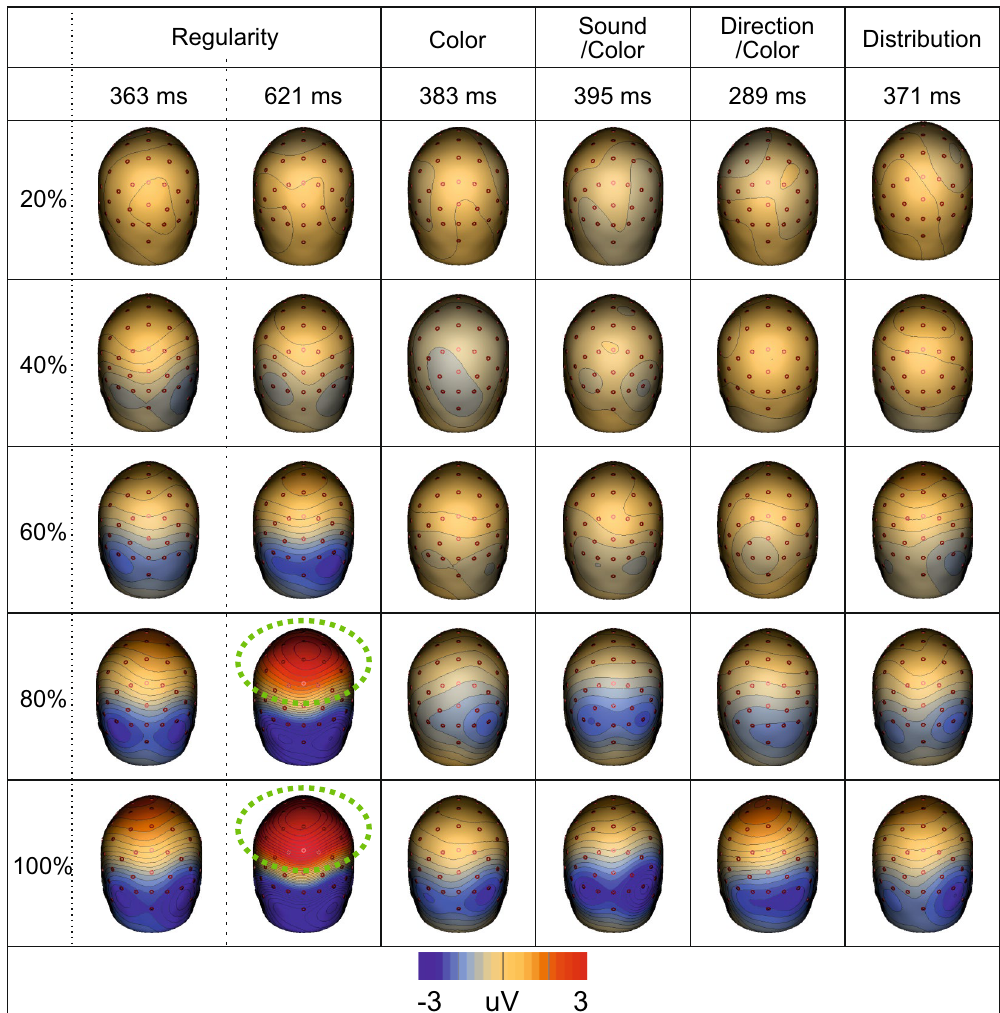
Figure 2. Scalp maps for each task and condition. Scalp maps at each distinct peak within the GFP for each task and each level of PSYMM. The vertex positivity is highlighted with green halos. Scalp maps were created using BESA 7.0 (https